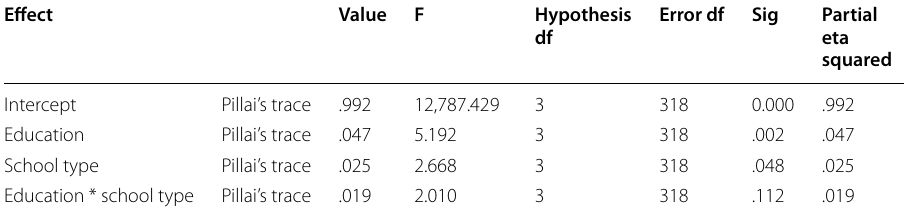
Table.5 Multivariate tests of education level and school